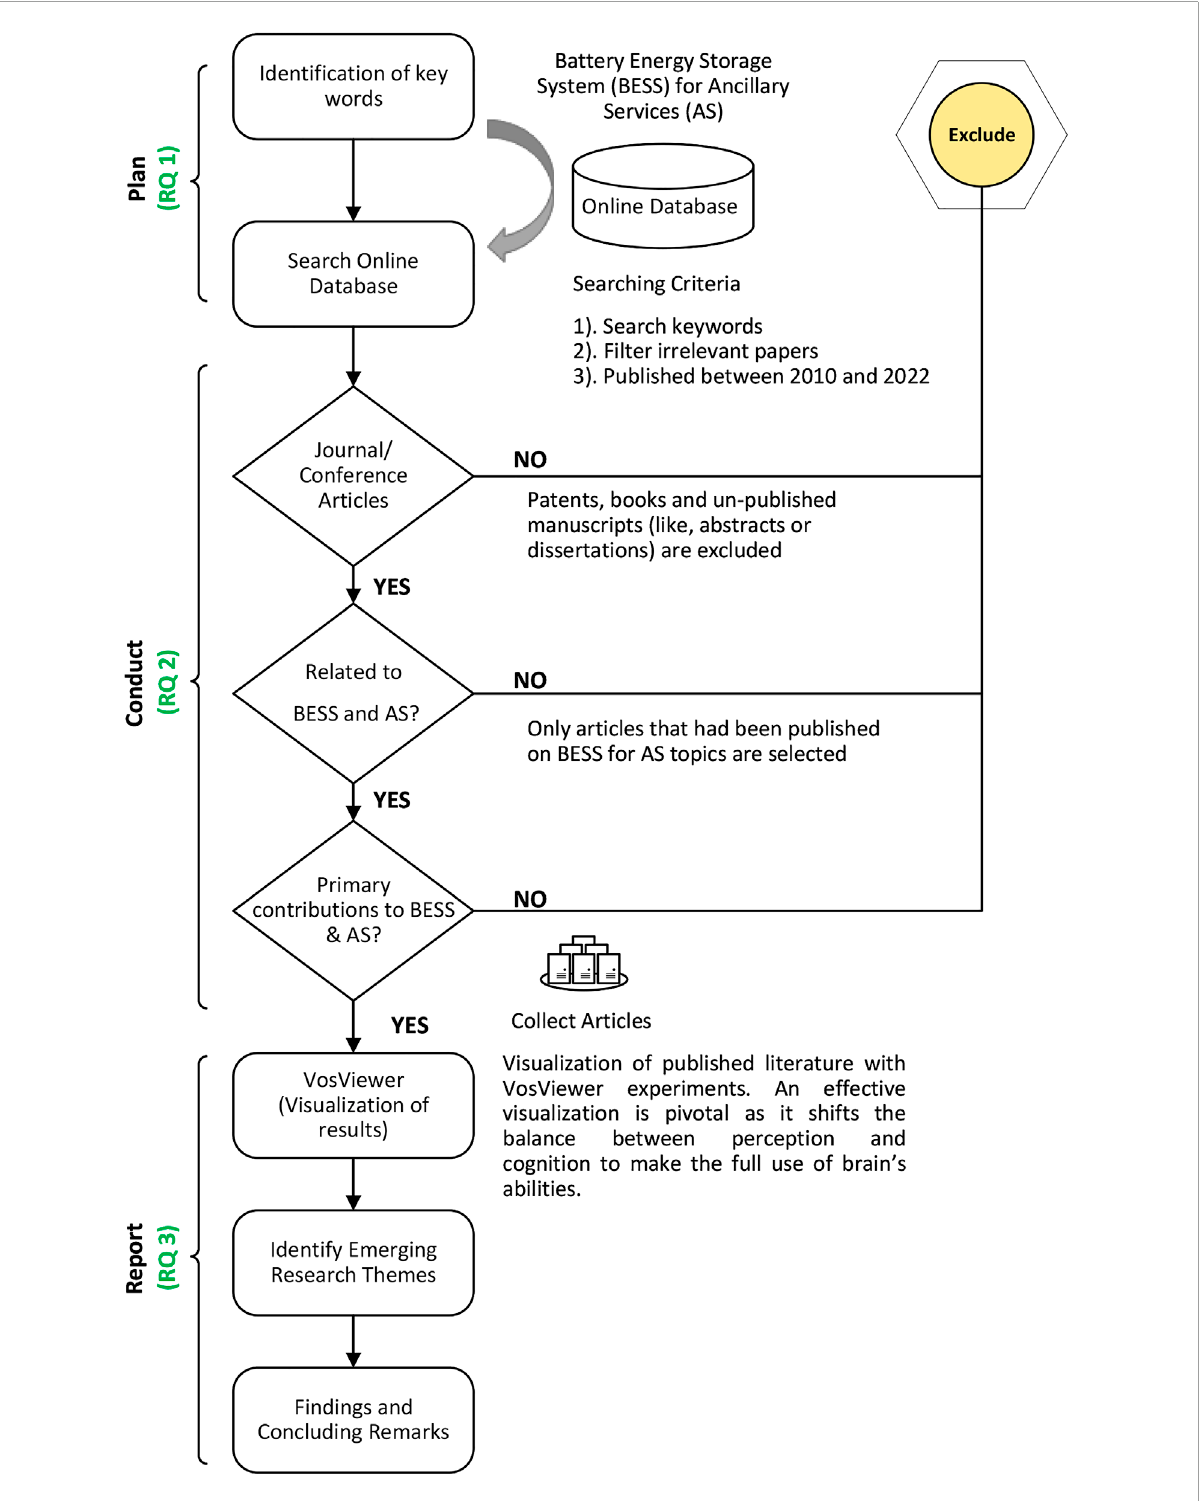
FIGURE 1 Review methodology used in this